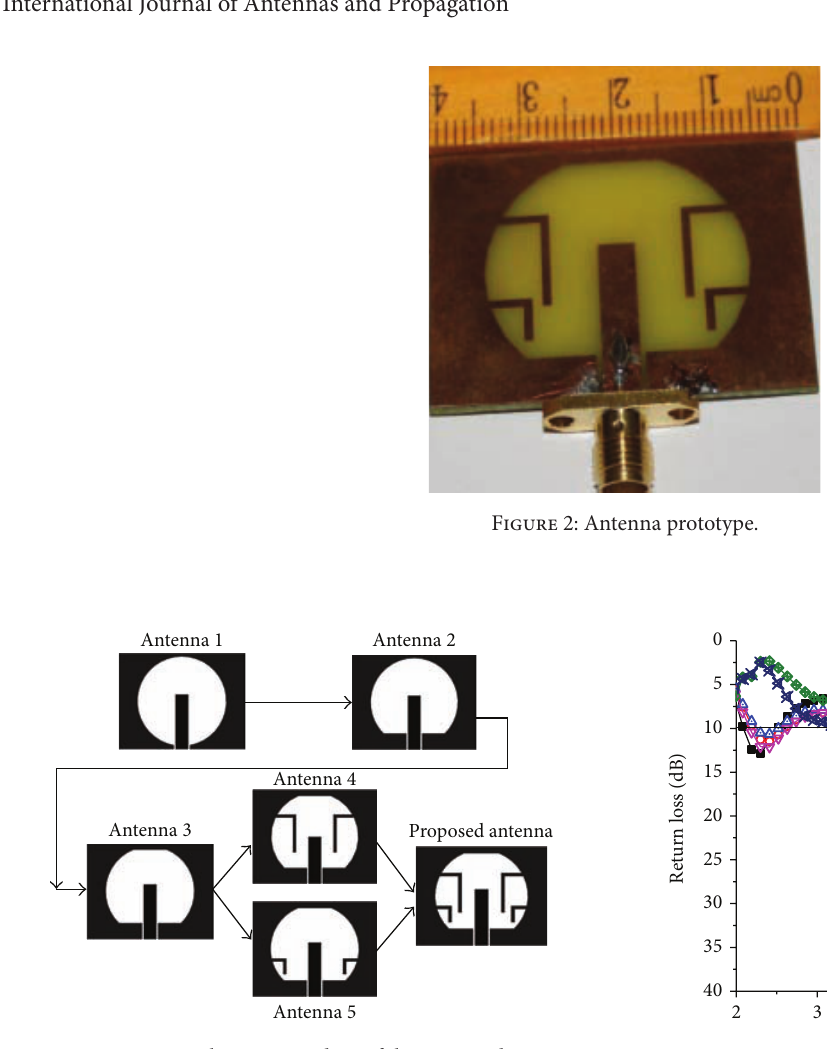
Figure 3: Design evolution procedure of the proposed antenna.